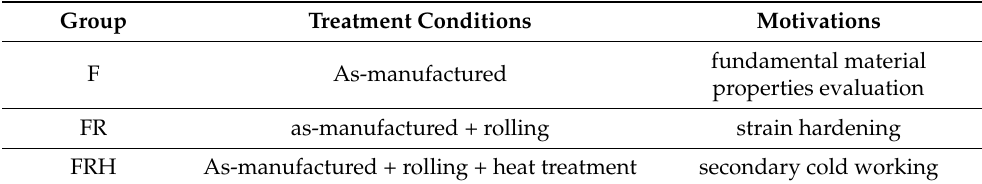
Table 2. Treatment conditions and motivations for each group.